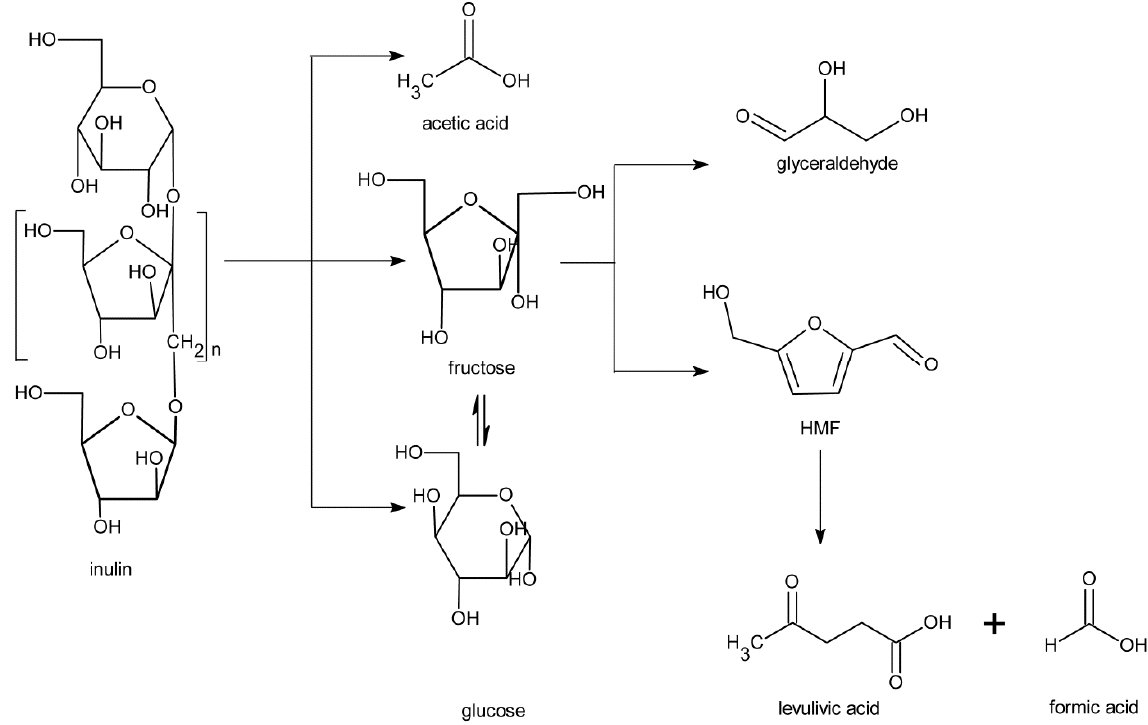
Figure 6. Proposed reaction network for inulin in copper (II) chloride